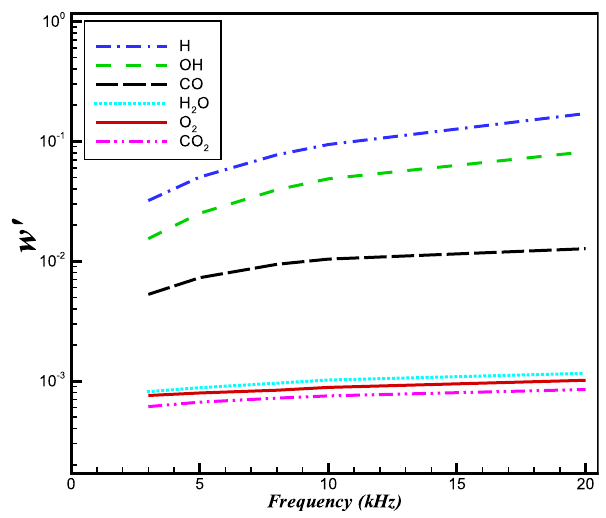
Figure 18. Relative change in the reaction rates of different species at a pressure perturbation of 100 Pa.